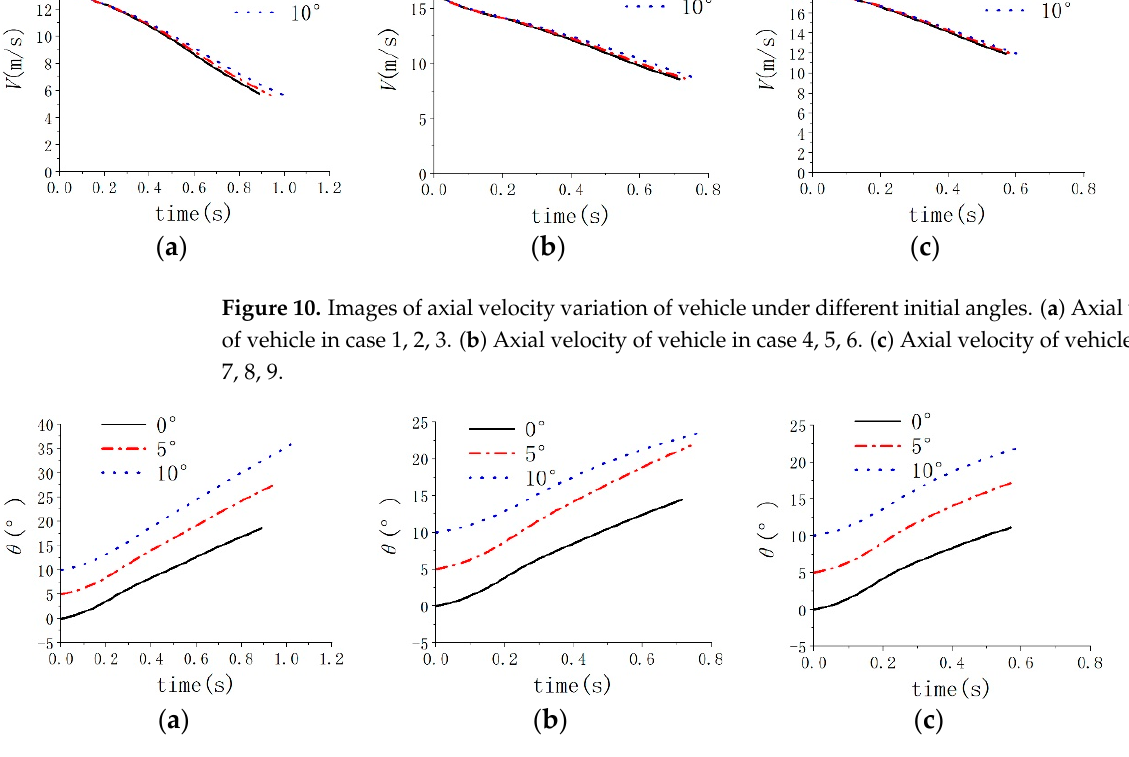
Figure 11. Images of pitch angle variation of vehicle under different initial angles. ( a ) Pitch angle of vehicle in case 1, 2, 3. ( b ) Pitch angle of vehicle in case 4, 5, 6. ( c ) Pitch angle of vehicle in case 7, 8, 9. Table 3. Pitch angle of vehicle.